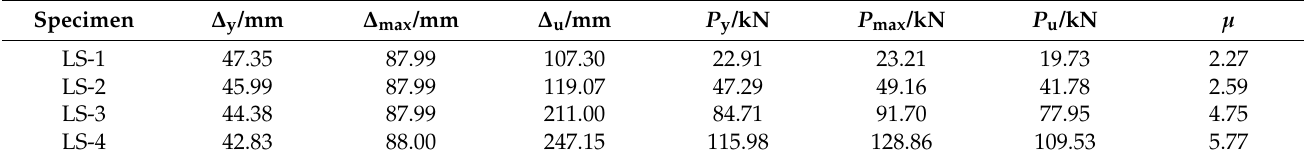
Table 15. Load-bearing performance and ductility index of LS specimens.